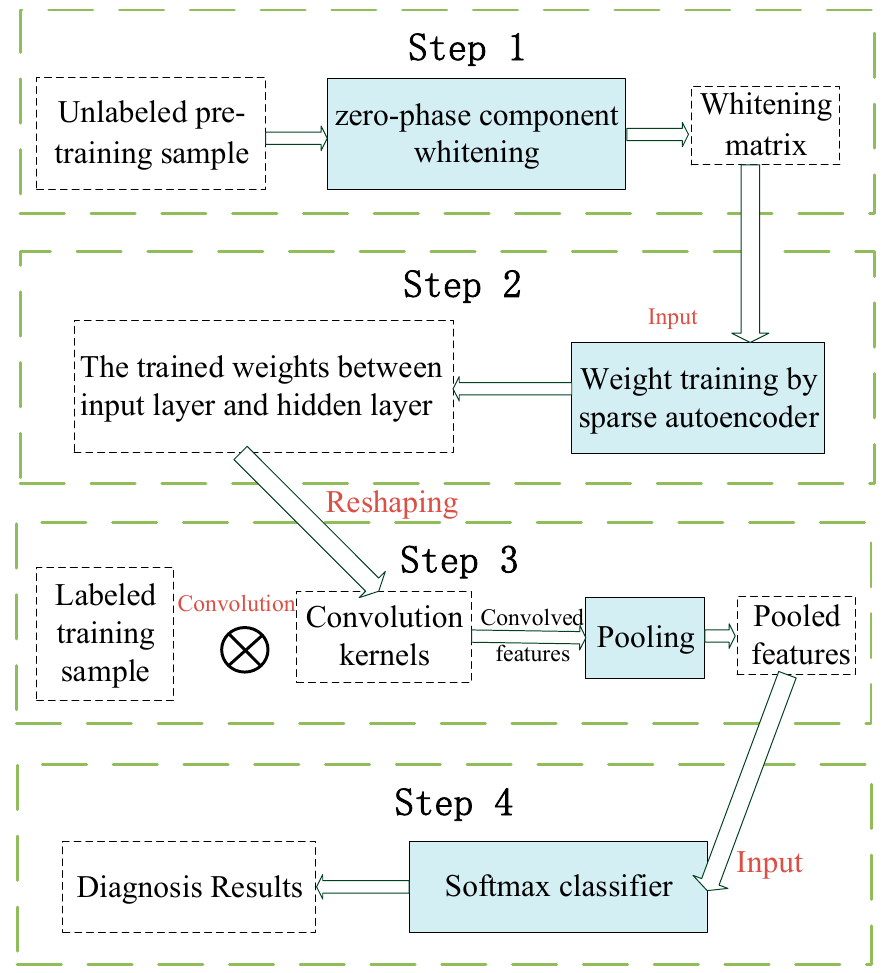
Figure 3. Frame of the proposed diagnosis method.